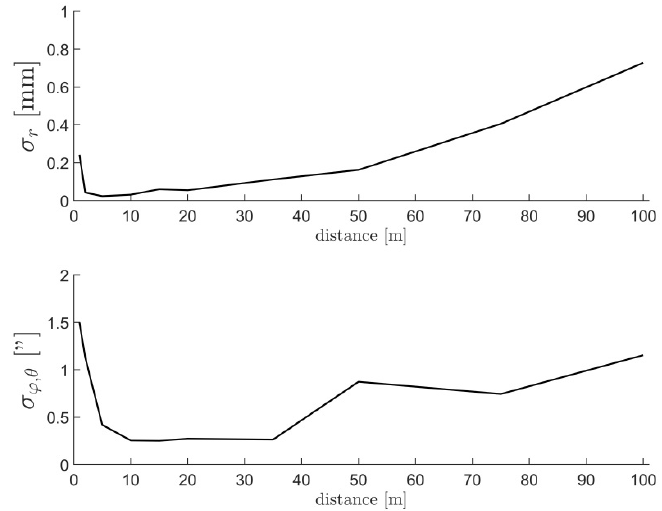
Figure 3. Target center uncertainty for range and angular measurements, with respect to the scanning distances.